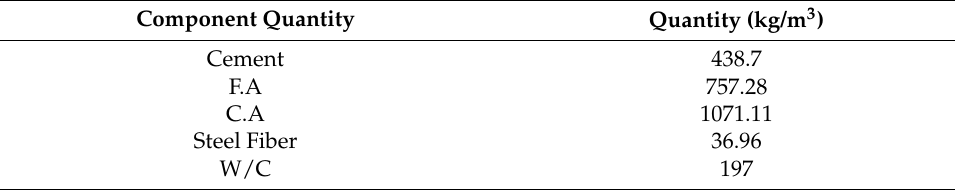
Table 2. M20 grade mix design as per IS 10262-2009.